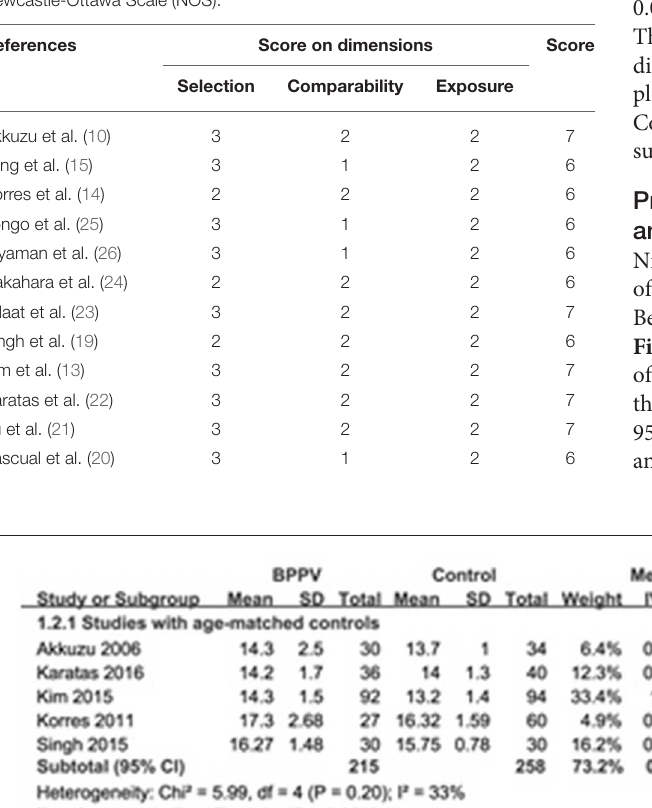
TABLE 3 | Quality assessment of the selected studies using the Newcastle-Ottawa Scale (NOS).